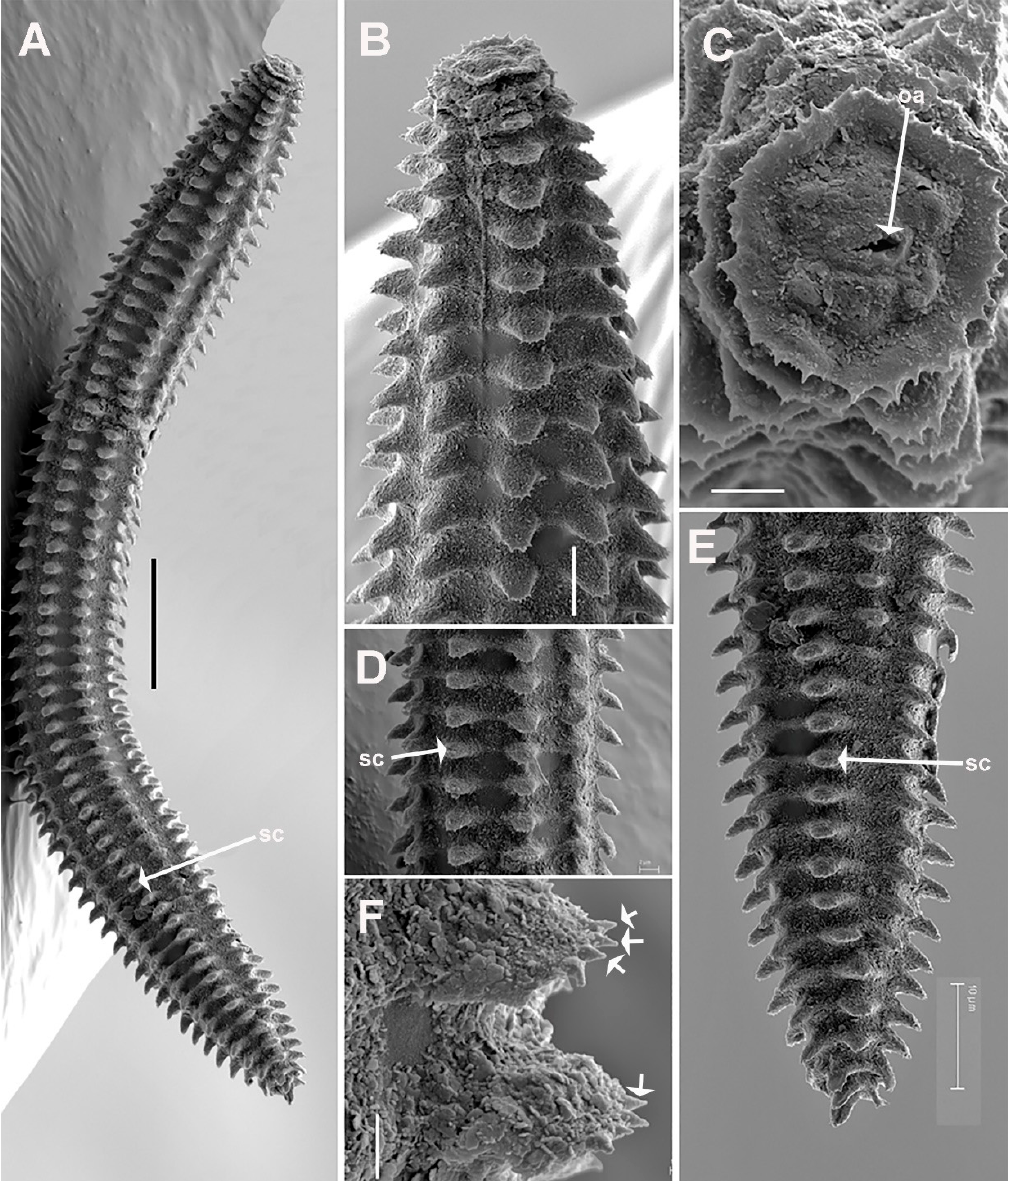
Figure 11. SEM micrographs of Criconema plesioannuliferum sp. nov. juveniles. ( A ), whole juvenile showing files of scales; ( B ), anterior region; (C), in face view; ( D ), mid-body region; ( E ), posterior region showing files of scales (arrowed); ( F ), detail of scales showing minute acute projections (arrowed). Abbreviations: oa = oral aperture; sc = scales. Scale bars: ( A ) = 25 µm; ( B ) = 5 µm; ( C , D ) = 2 µm; ( E ) = 10 µm; ( F ) = 1 µm.